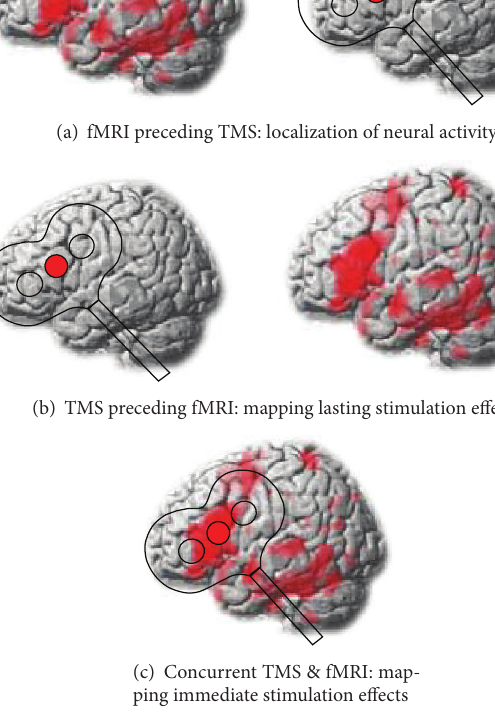
Figure 1: Illustration of different combinations of transcranial magnetic stimulation (TMS) and functional magnetic resonance imaging (fMRI). (a) fMRI can be used to localize target areas for TMS application. Subsequently, TMS is applied to probe the contribution of these regions to a specific task. (b) TMS can also be applied prior to fMRI to probe its lasting neuromodulatory effects on the network level. (c) Simultaneous TMS and fMRI can be used to map the immediate consequences of TMS on brain